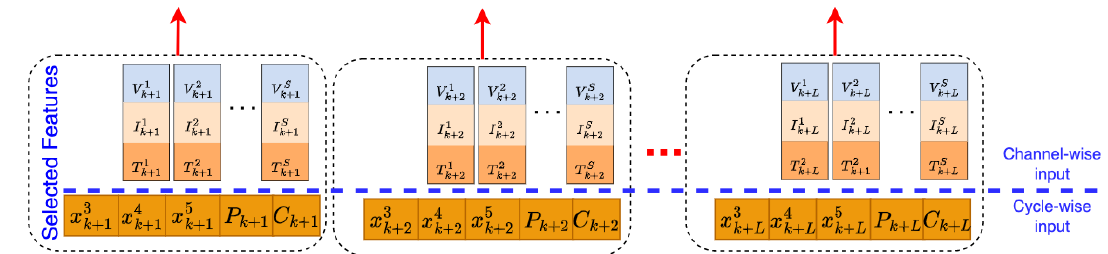
Figure 8. Summary of the cycle-wise and channel-wise input in our method.